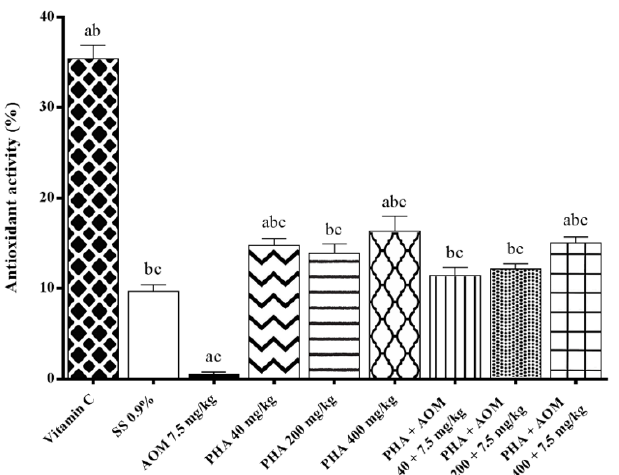
Figure 5. Antioxidant capacity of phaseolin (PHA) determined with the DPPH assay in the sera of mice treated with azoxymethane (AOM). Each bar represents the mean ± SEM from six mice per group (8 groups). a Statistically significant difference with respect to the control, saline solution (SS)-treated group, b with respect to the group treated with AOM, and c with respect to the value obtained in mice administered vitamin C. ANOVA and Holm-Šídák tests, p < 0.05.